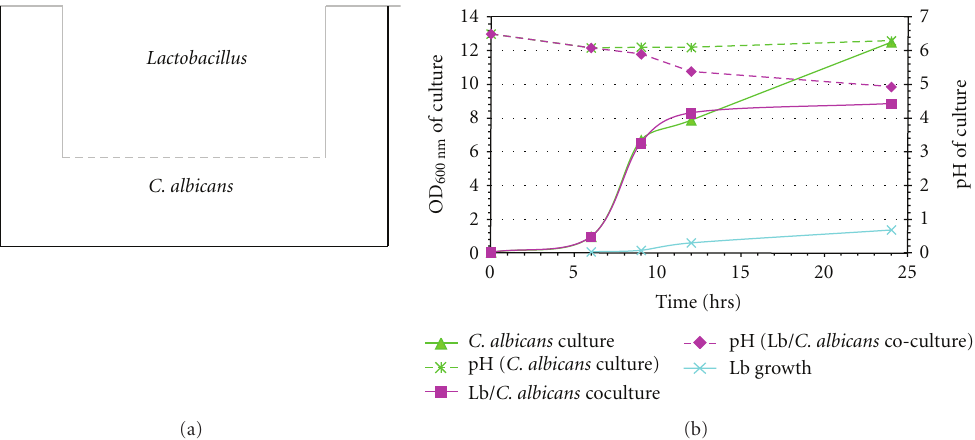
Figure 5: Lactobacillus - C. albicans cocultures for transcriptome analysis. The experimental setup employing a 0.45 µ m membrane for separation of the bacterial and fungal cultures in 6-well tissue culture plates is represented schematically in (a). Results of a typical Lactobacillus - C. albicans coculture and C. albicans -only control experiment are shown in (b). Growth of C. albicans and Lactobacillus (Lb) in the respective compartments was determined by OD 600nm readings (left y -axis). The pH of the culture media is depicted in dashed lines using the right y -axis. For transcriptome analysis, total RNA was isolated from C. albicans cells harvested from cocultures and